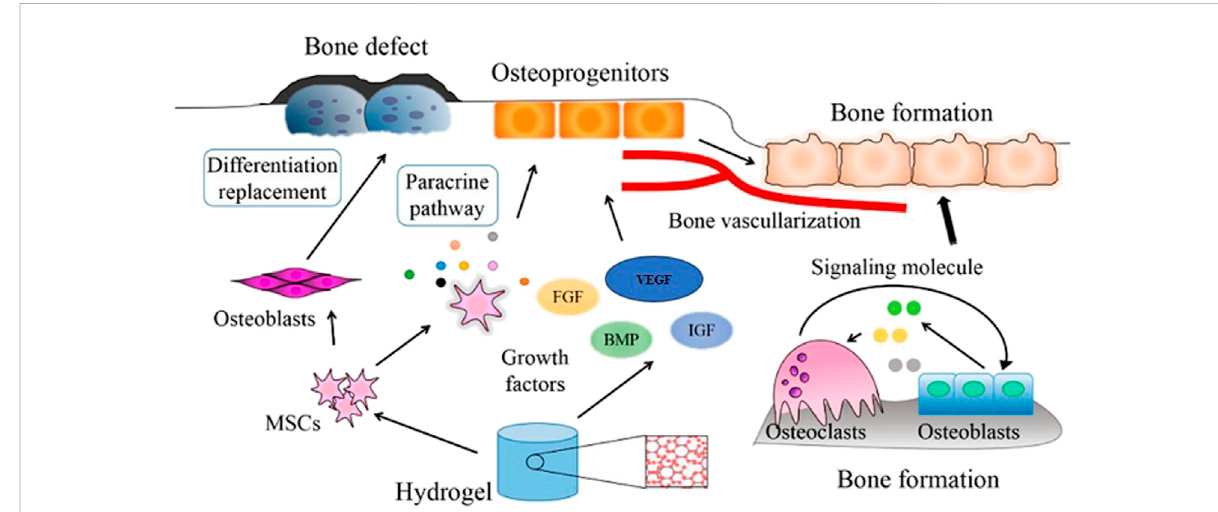
FIGURE 6 Mechanism of action of cells and growth factors incorporated into a bone-repair scaffold (Reproduced with permission from Ref (Yue et al., 2020) under Creative Commons Attribution License (CC